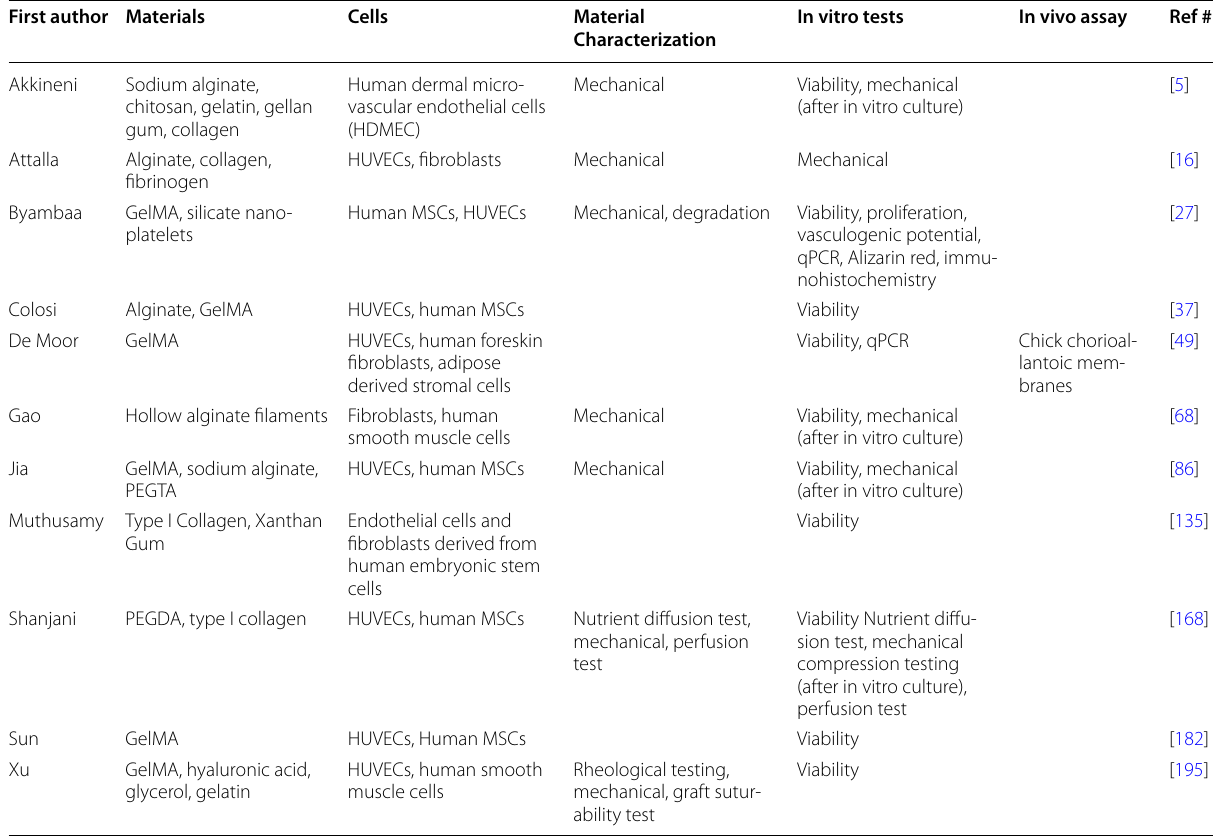
Table 3 Vasculature 3D bioprinting: materials, cells and characterizations First author